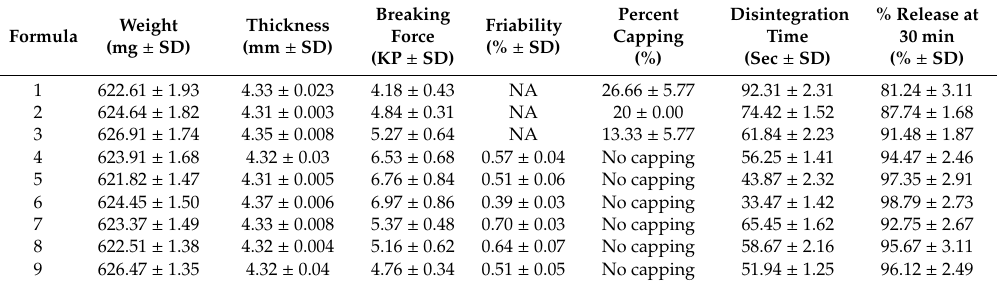
Table 8. Quality attributes of prepared metformin hydrochloride orally disintegrating tablets (mean ± SD).